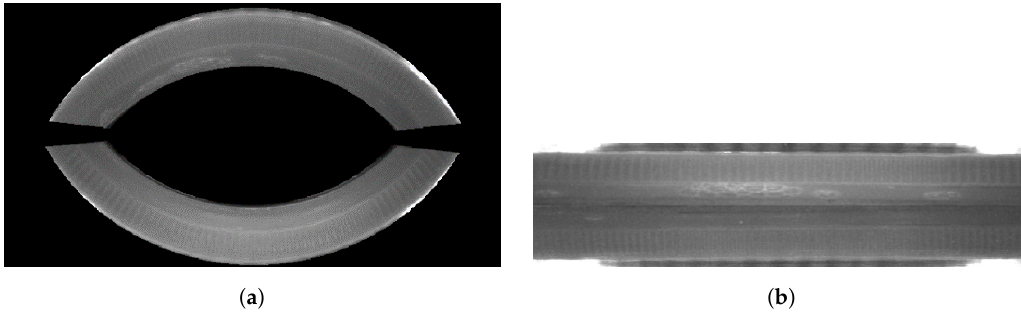
Figure 8. Image of side surface of a cap: ( a ) masked image after cutting out unnecessary background; and ( b ) image that is a combination of mirrors images after